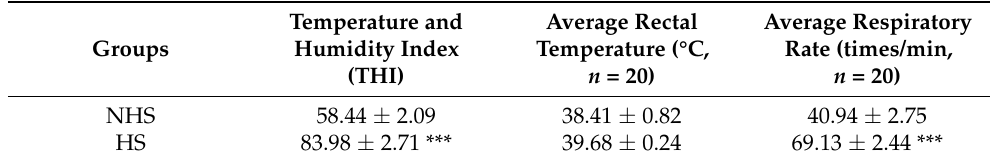
Table 2. Environmental temperature and humidity index (THI), and rectal temperature and respira- tory rate of Holstein dairy